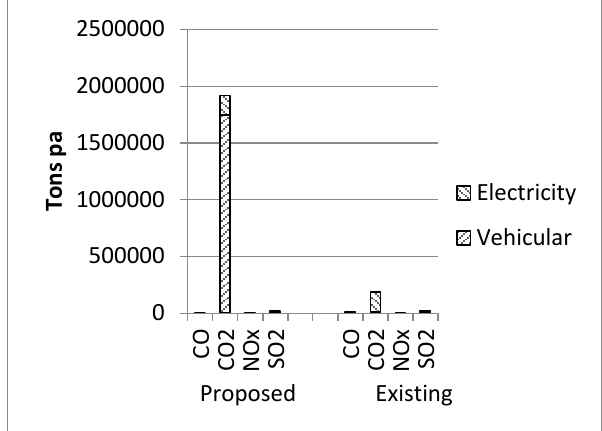
Figure 10. Comparison of Greenhouse gas emissions from electricity production and private